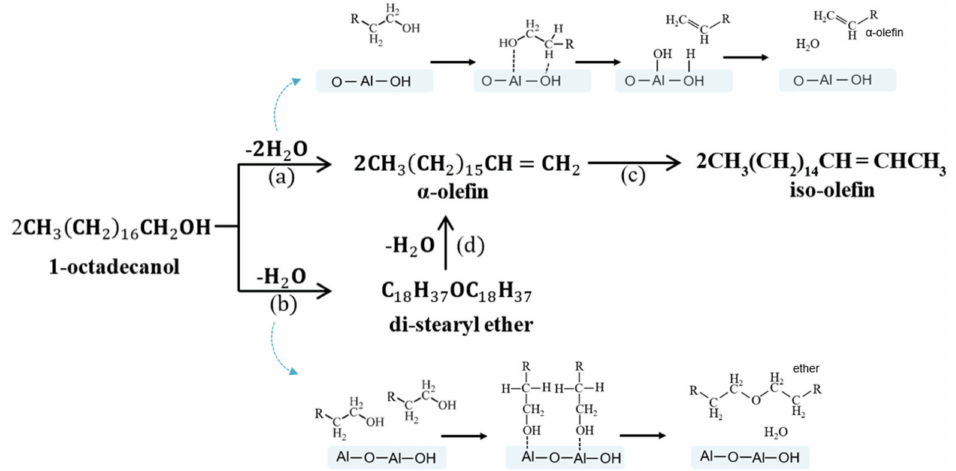
Figure 7. Possible dehydration reaction routes of 1-octadecanol: ( a ) intramolecular route; ( b ) inter- molecular way; ( c ) re-adsorption of LAO on LAS on the surface of alumina, and ( d ) di-stearyl ether intermediate decomposition into LAO and